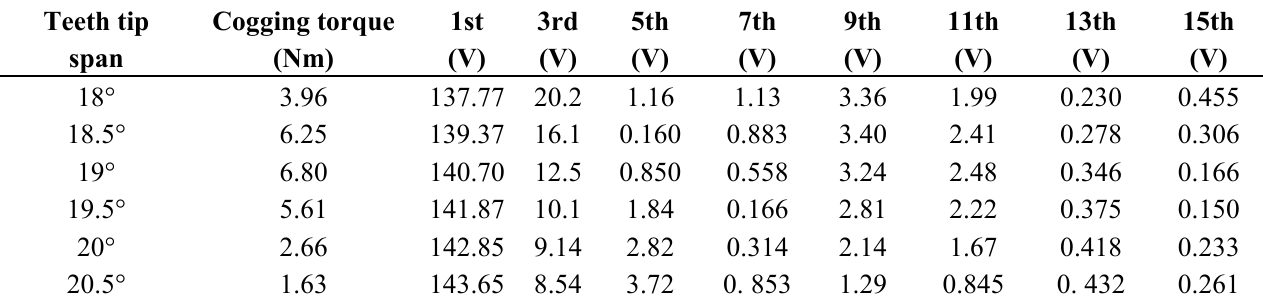
Table 5. Cogging torque and harmonic components of back EMF.